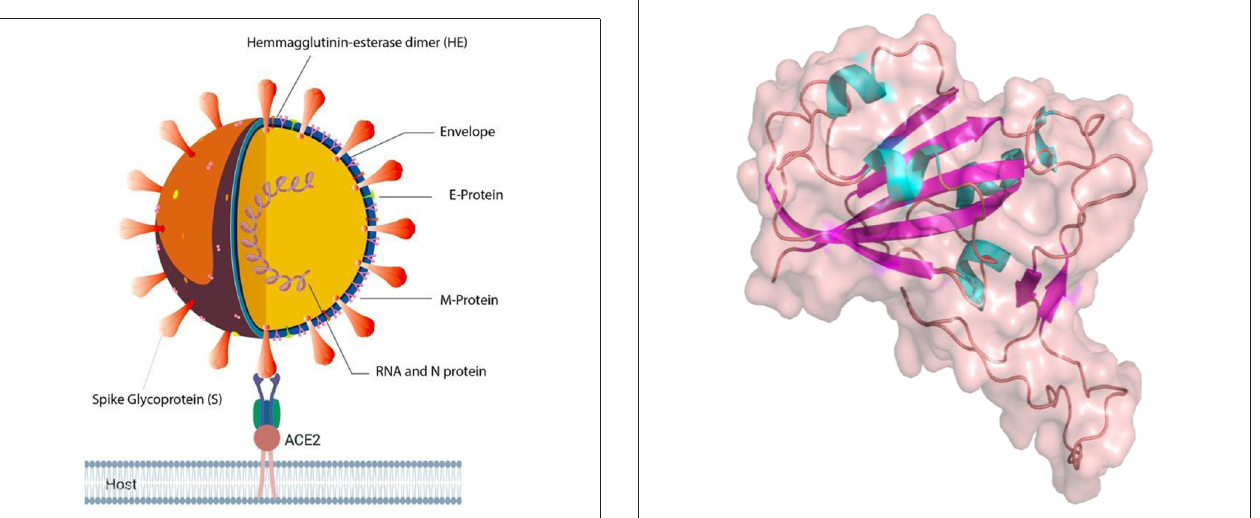
FIGURE 1 | Illustration of SARS-CoV-2 in complex with Human ACE2 receptor.